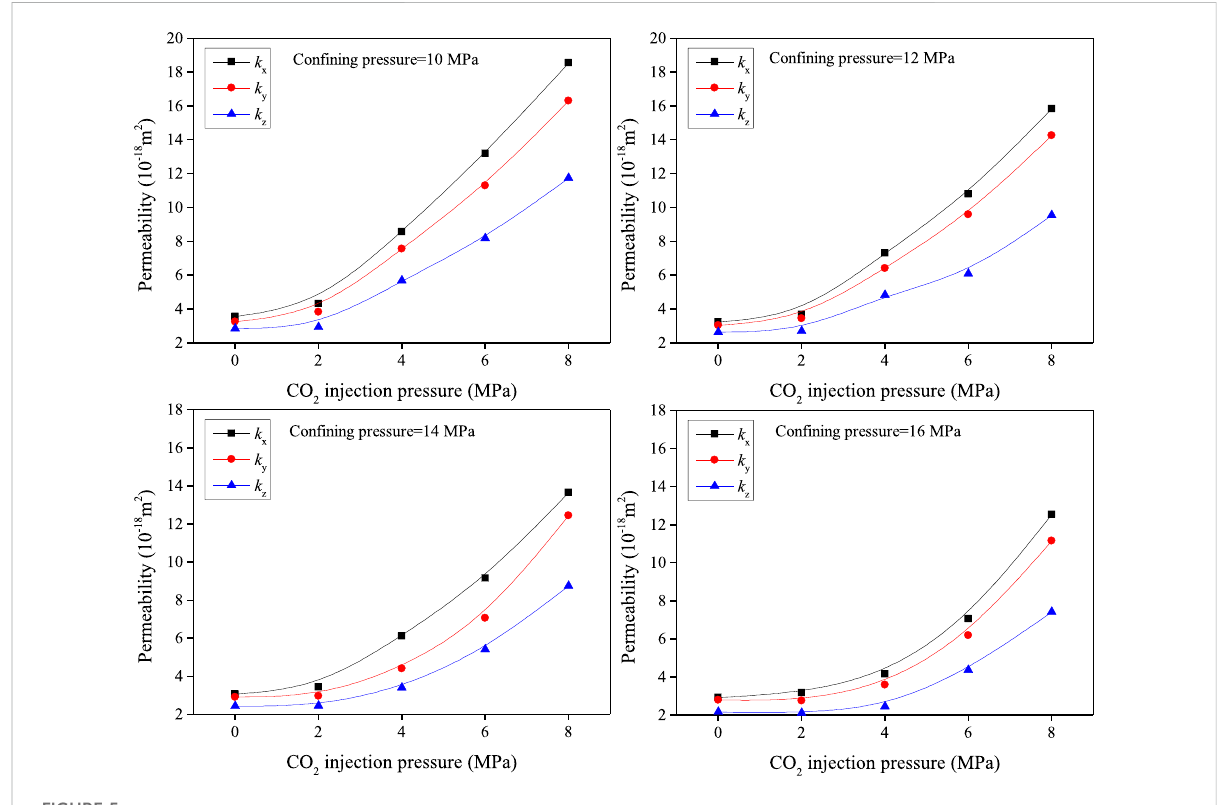
FIGURE 5 Changes in the permeability of cubic sample with the increasing CO 2 injection